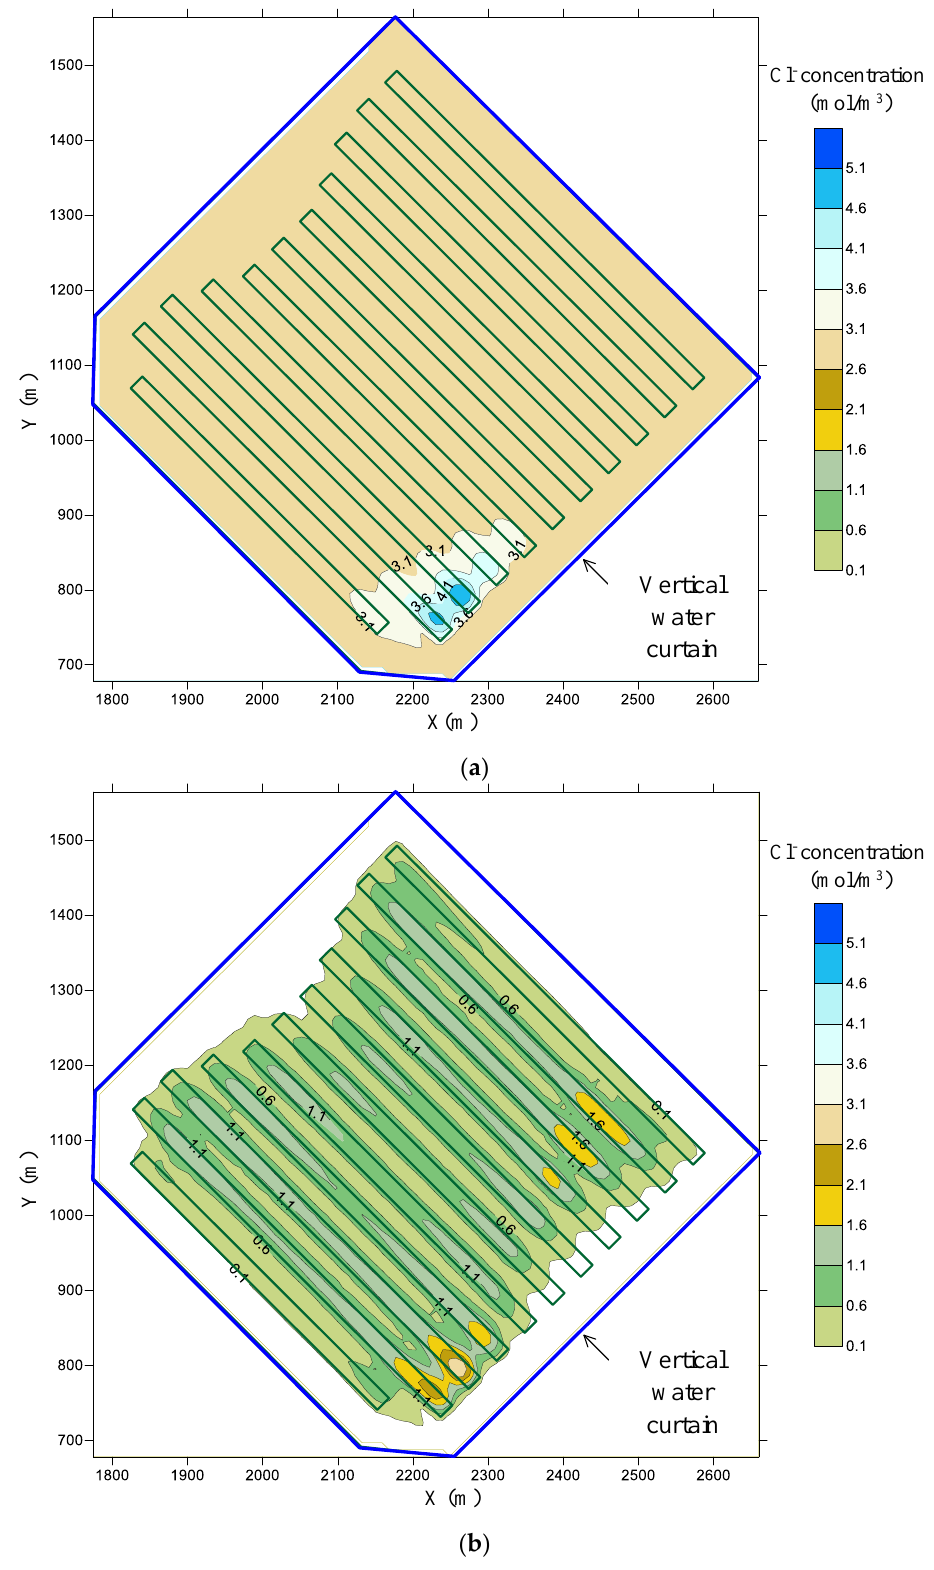
Figure 21. Cl − concentration on the bottom of the cavern after 50 years of operation: ( a ) groundwater injected into the water curtain system; ( b ) freshwater injected into the water curtain system.